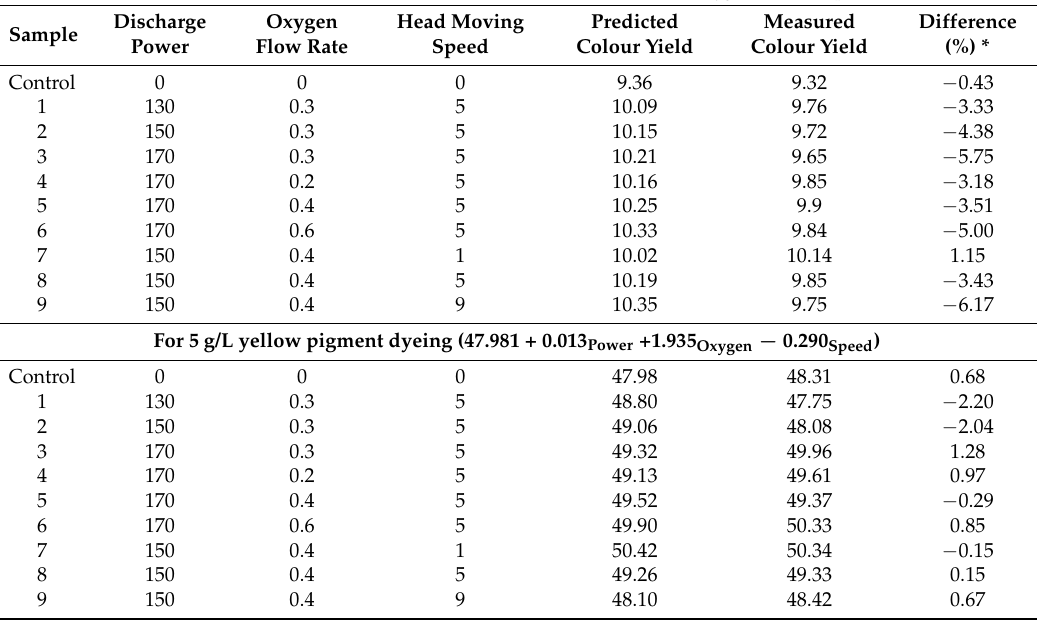
Table 10. Verification of Y 1 and Y 2